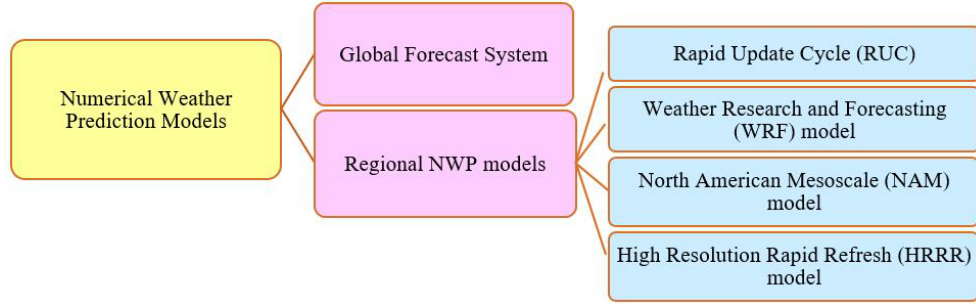
Figure 5. Classification of forecasting models based on NWP physical system [55].